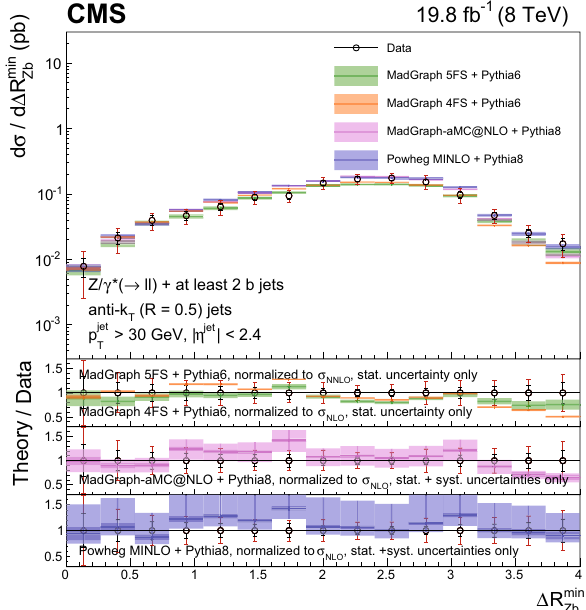
Fig. 15 Differential fiducial cross section for Z(2b) production as a function of Δ R bb , compared with the MadGraph 5FS, MadGraph 4FS, MadGraph5 _a MC@NLO , and powheg minlo theoretical pre- dictions ( shaded bands ), normalized to the theoretical cross sections describedinthetext.Foreachdatapointthestatisticalandthetotal(sum in quadrature of statistical and systematic) uncertainties are represented by the double error bar . The width of the shaded bands represents the uncertainty in the theoretical predictions, and, for NLO calculations, theoretical systematic uncertainties are added in the ratio plots with the inner darker area representing the statistical component only